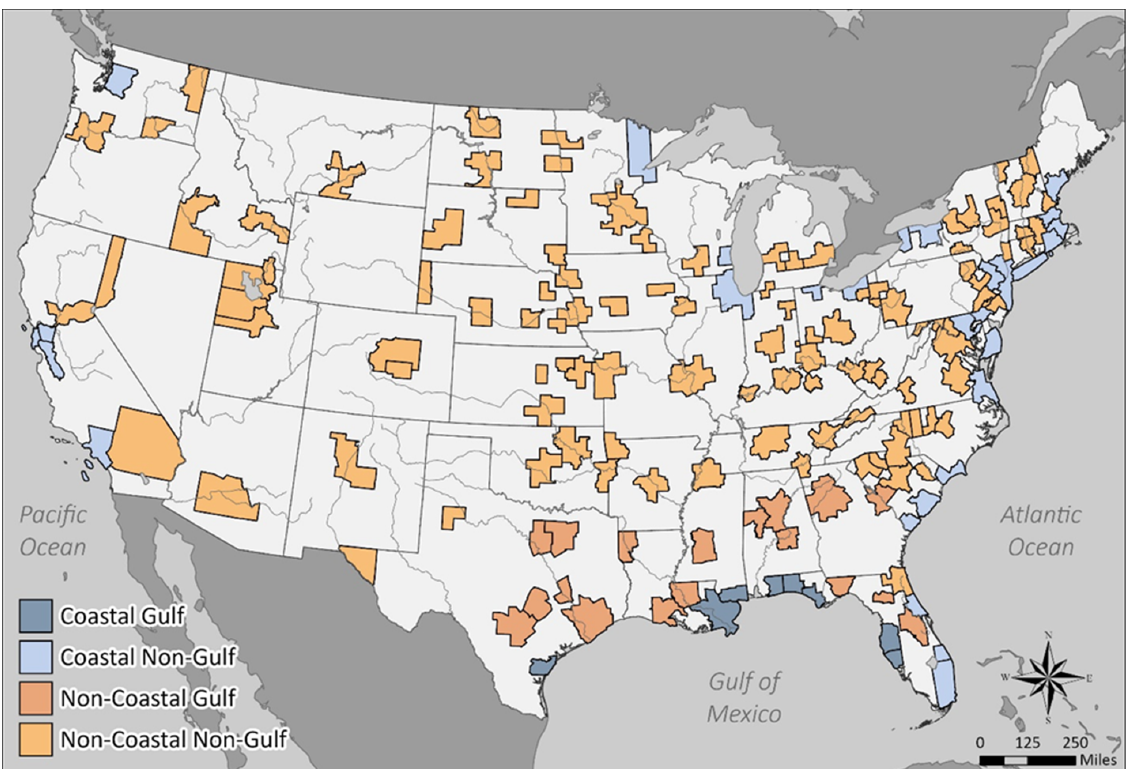
Figure 1. Map of the continental United States showing the location of all 165 MMSAs included in the study.